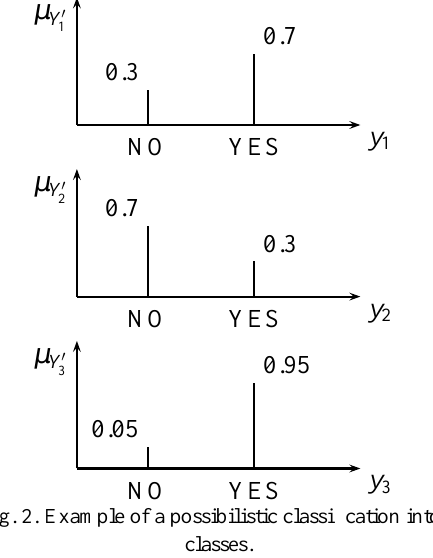
Fig. 2. Example of a possibilistic classification into 3